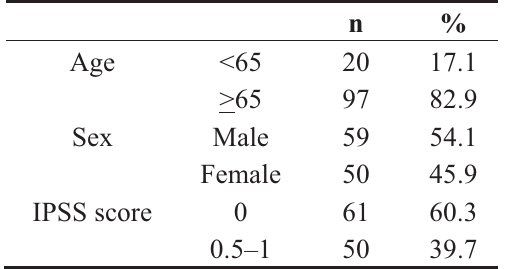
Figure 4. Hypermethylation of the VTRNA1-3 promoter associates with poor outcome in lower risk MDS patients. Patients with <20% mean methylation of the VTRNA1-3 promoter in their BM cells have a significantly better 5-year overall survival than patients exhibiting (cid:2)20% mean methylation. A break in the line indicates a censored event. Table 1. Clinical characteristics of lower risk